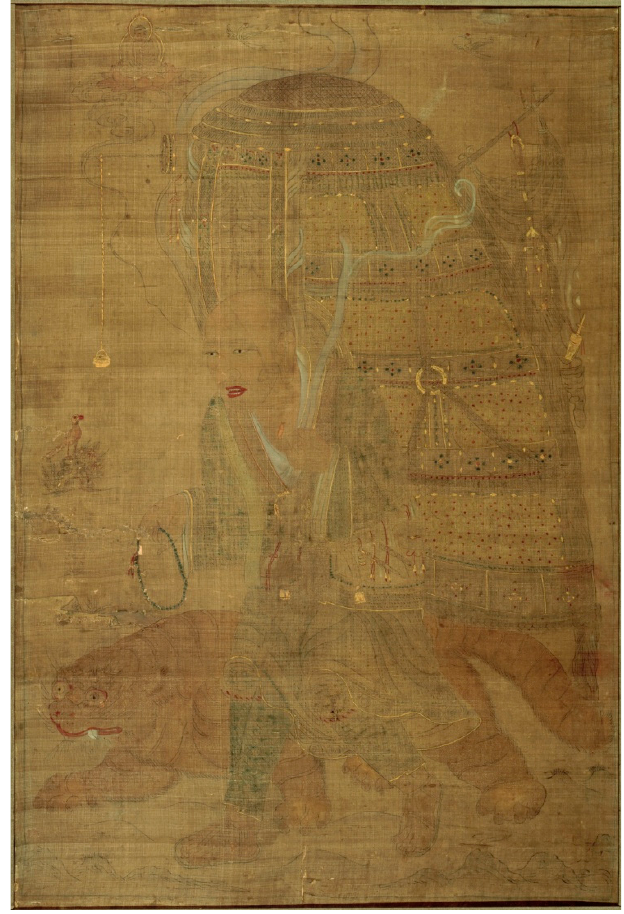
Figure 3. Itinerant Monk . Dunhuang, 9th century. Ink and colors on silk, 79.0 × 53.0 cm. Musée Guimet (EO.1138). Photo © BnF, Dist, RMN-Grand Palais/image BnF.